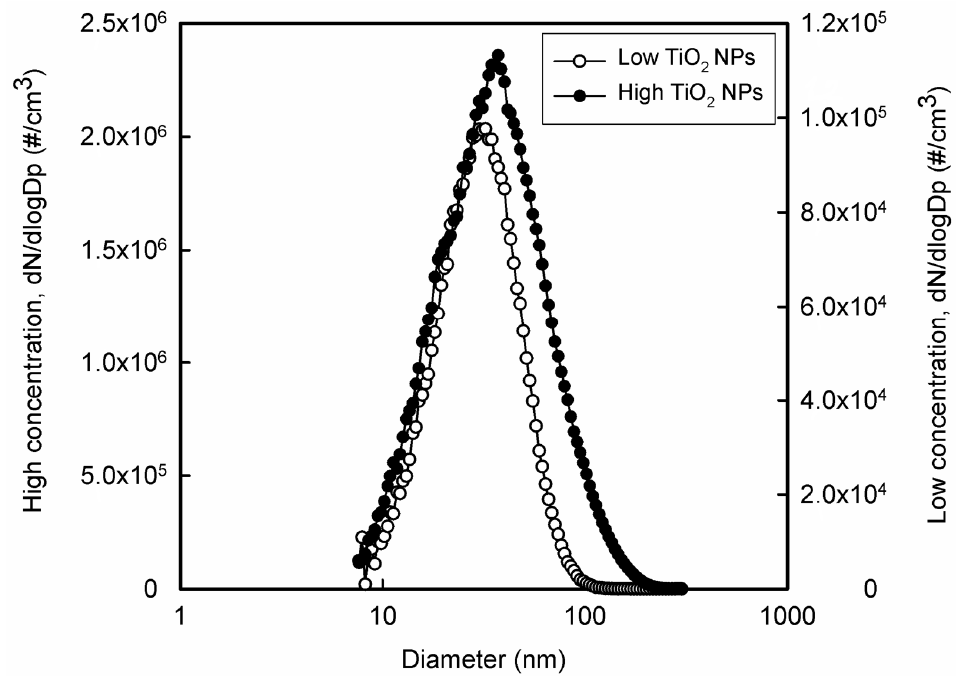
Figure 2. The number size distribution of TiO 2 NPs for low NP concentration (5.06 × 10 4 particles/cm 3 ) and high NP concentration (1.51 × 10 6 particles/cm 3 ). x-axis, particle diameter (a logarithmic scale); y-axis, number concentration of particles (the number concentration is normalized by the size range of particles)